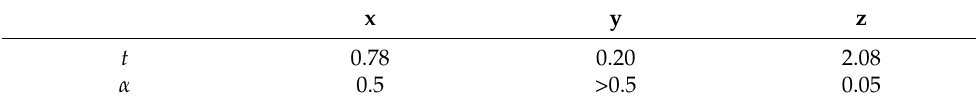
Table 6. Result of independent 2-sample t